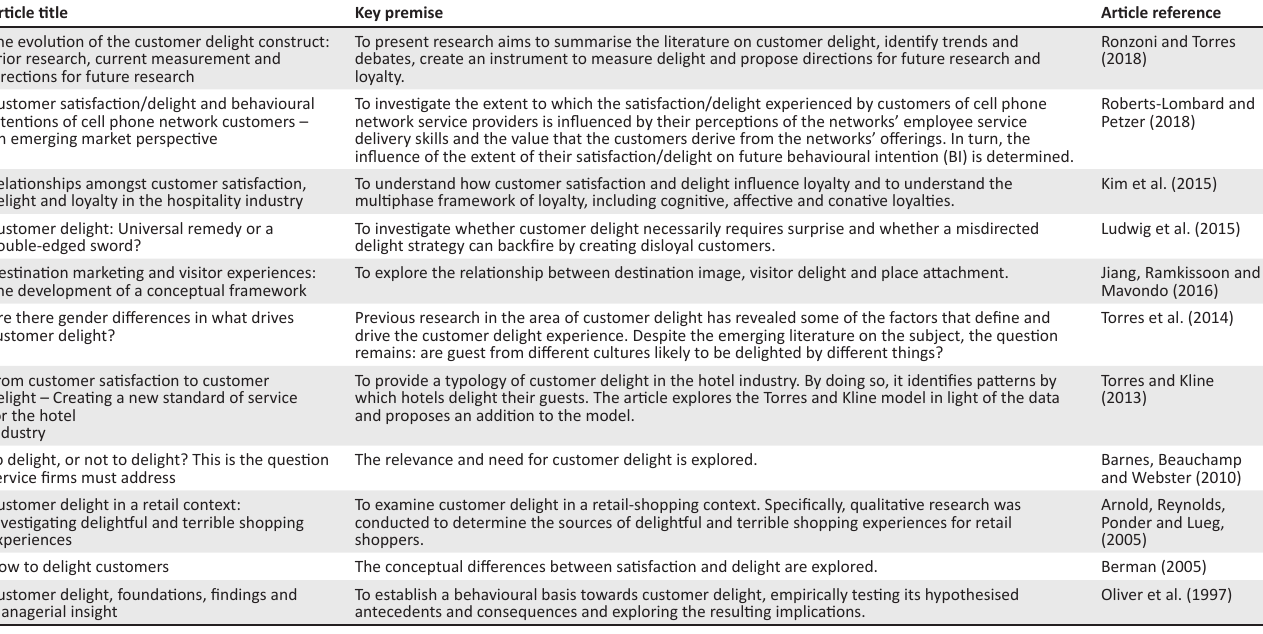
TABLE 1: Previous research studies conducted on delight in the world over the past three